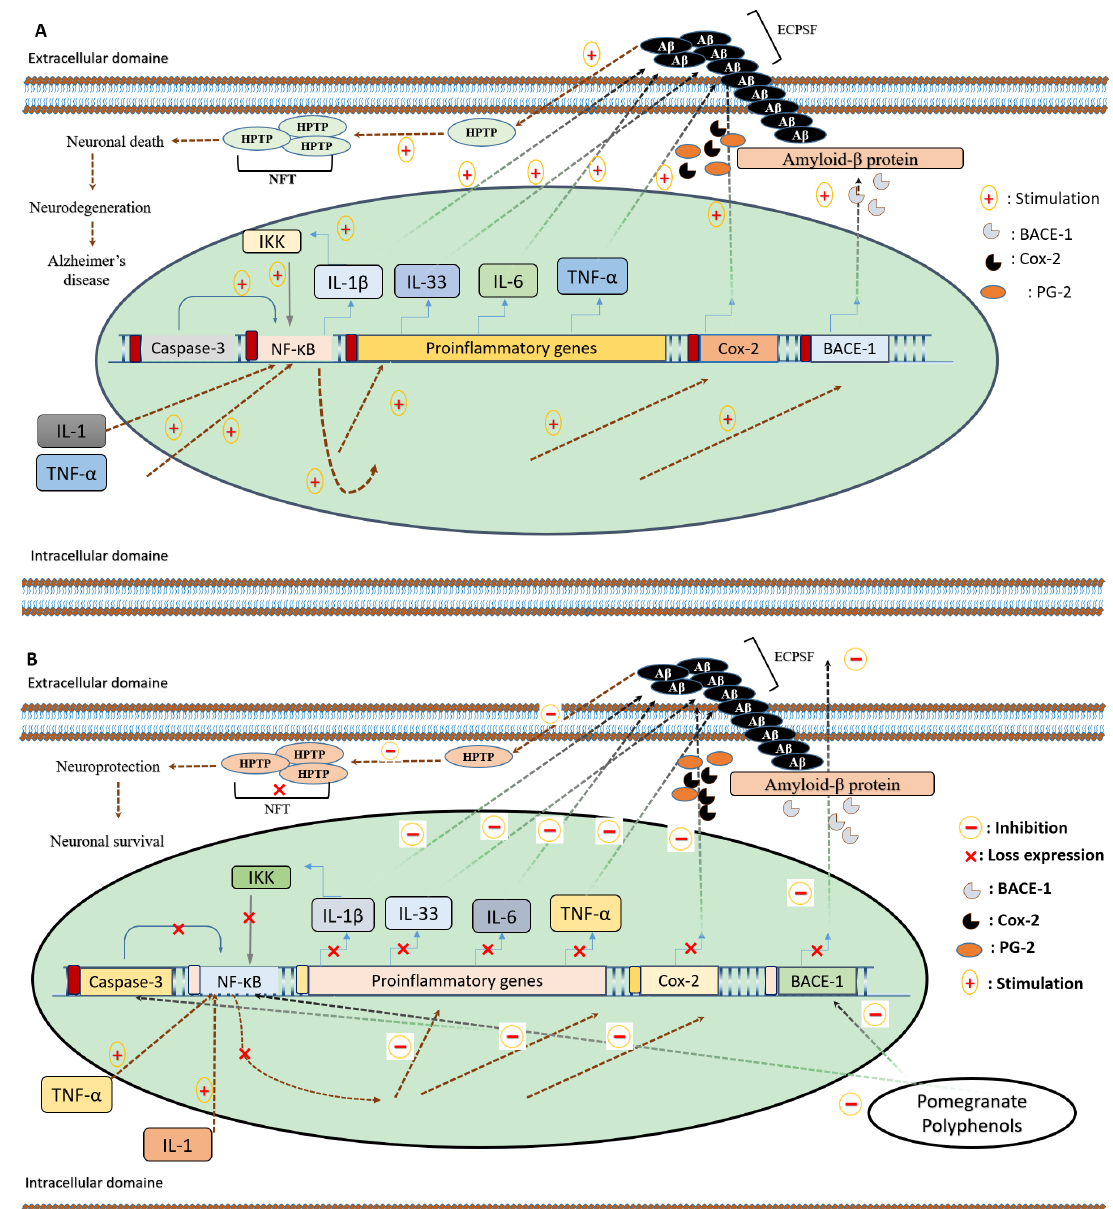
Figure 1. ( A ) The involvement of neuro-inflammation in Alzheimer’s disease. ( B ) The proposed operative anti-neuroinflammatory mechanism and amyloidogenic inhibitory effects of pomegranate bioactive compounds.